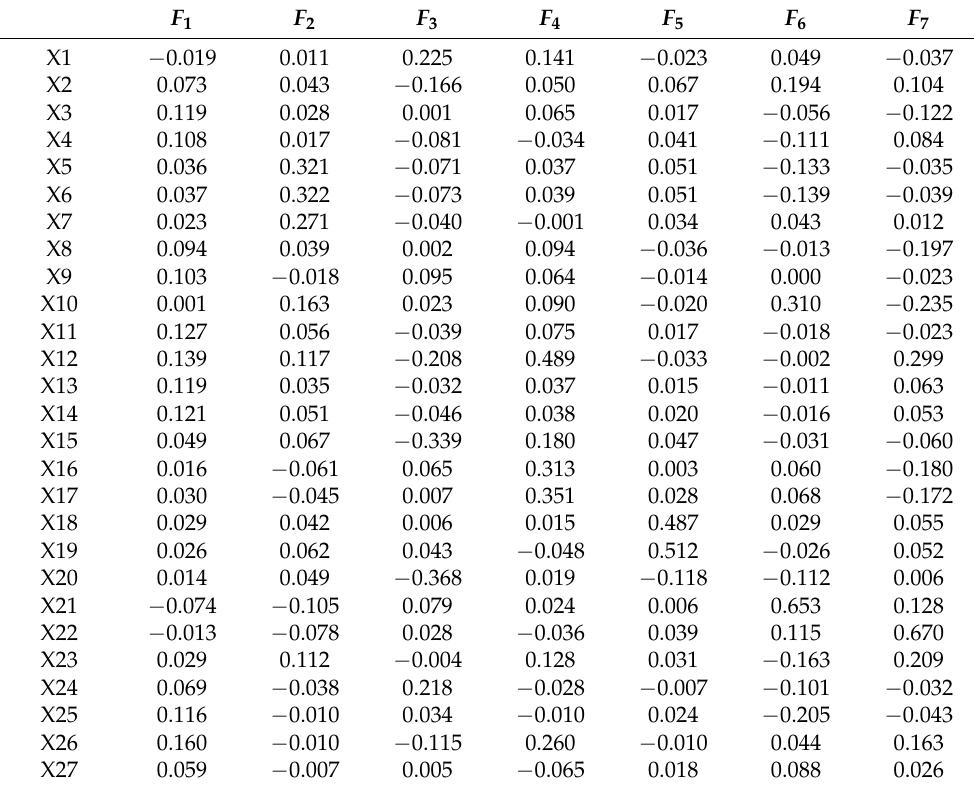
Table A4. Coefficient matrix of component